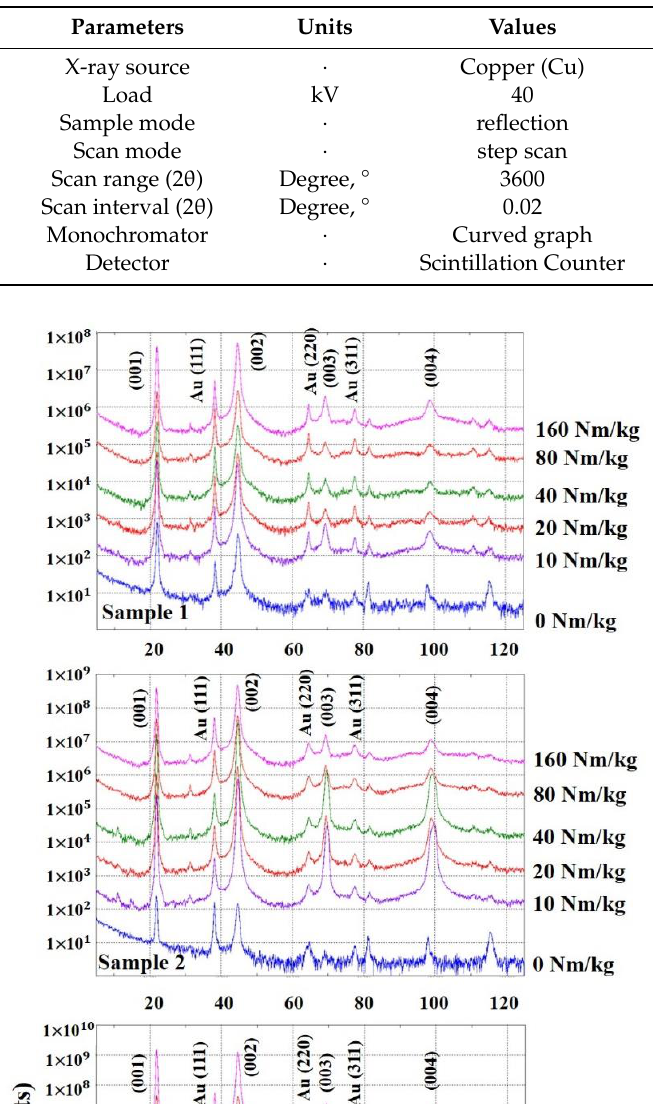
Table 1. Measurement conditions of X-ray diffractometry.